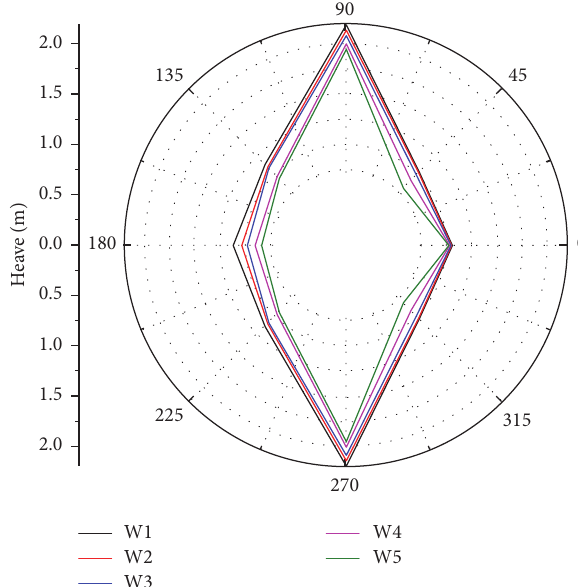
Figure 12: Results of heave in irregular waves.